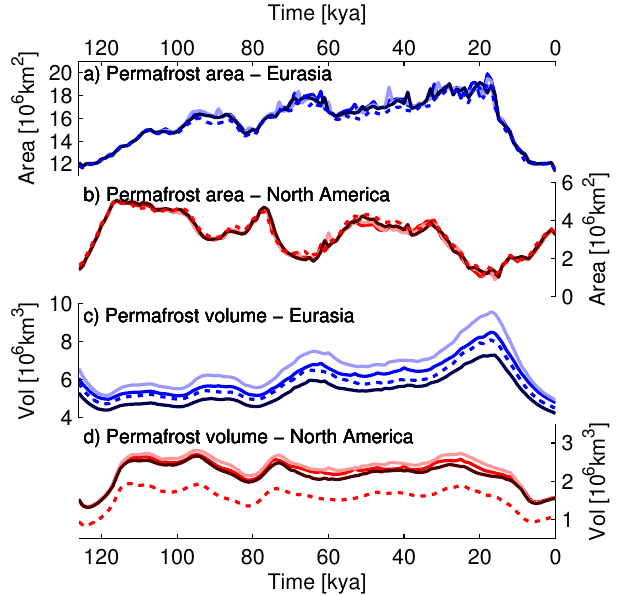
Figure 10. Evolution of permafrost area and permafrost volume over the last glacial cycle. Eurasian (a) and North American (b) per- mafrost area excluding ice-covered grid cells. Eurasian (c) and North American (d) permafrost volume. Solid lines represent sim- ulations with surface porosity of 0.25, 0.5 and 0.75 (from light to dark) and the dotted lines are from the model run with the geother- mal heat flux from Davies (2013).